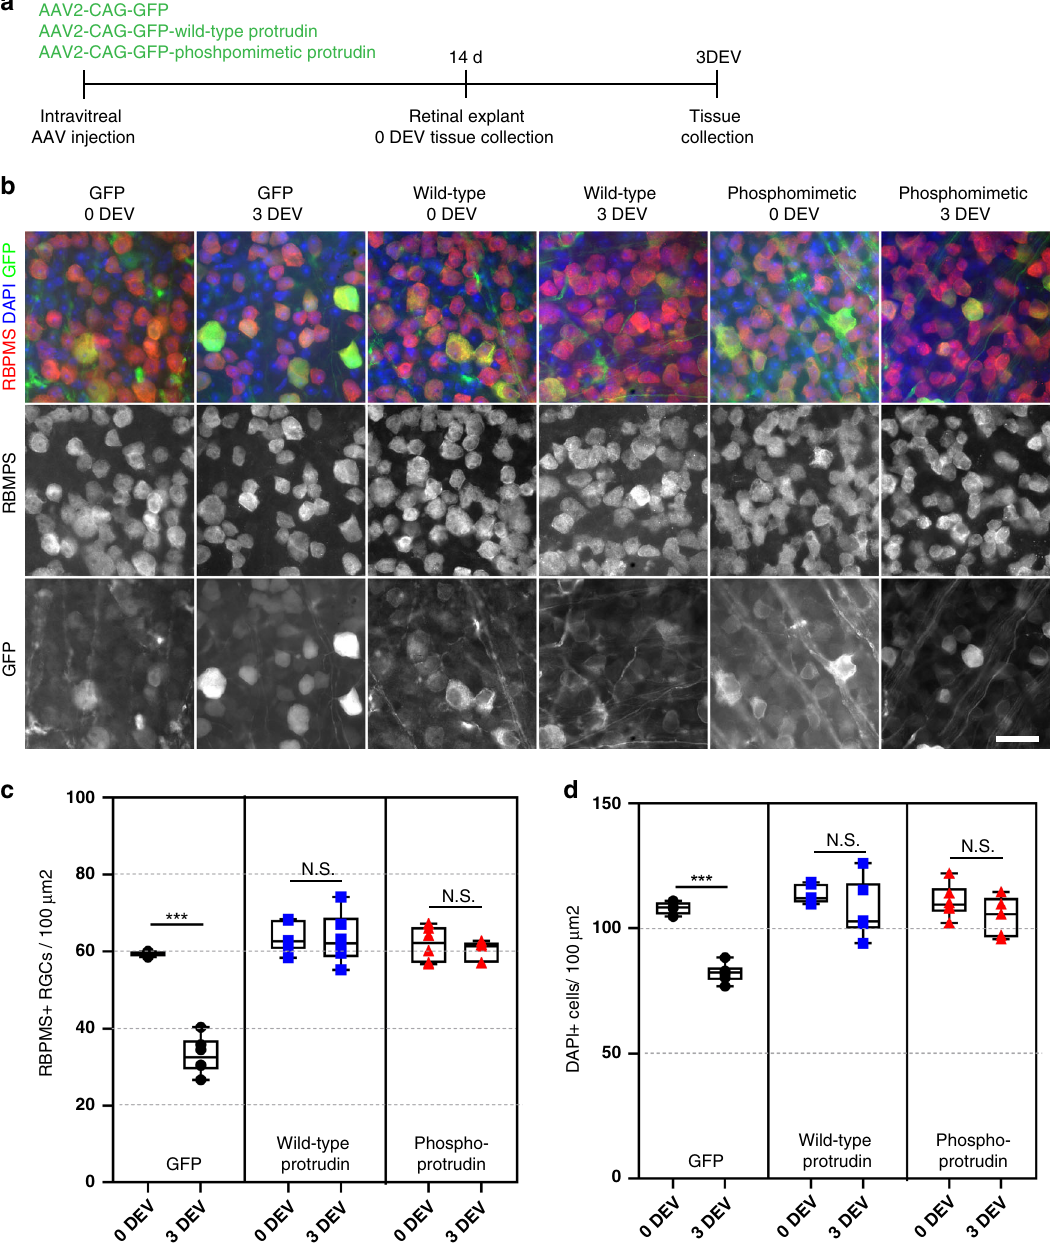
Fig. 6 Protrudin is neuroprotective to RGCs and other cell types in the retina after a retinal explant. a Experimental timeline for retinal explant experiment. b Representative images of RGCs (red for RBPMS) 0 and 3 days ex vivo (DEV) in eyes injected with control virus, wild-type Protrudin or phosphomimetic Protrudin (green for GFP) and stained for DAPI (blue). Scale bar is 20 µ m. c Quanti fi cation of RGC survival in retinal explant ( n = 4 – 6 animals for each condition) (Two-tailed Student ’ s t -test). ** p < 0.005, *** p < 0.001, **** p < 0.0001. Individual p values are as follows: p < 0.0001 for GFP, p = 0.945 for WT and p = 0.439 for phosphomimetic Protrudin when compared at 0 DEV to 3 DEV. The box plots show the fi rst and third quartiles (the box limits), the median (horizontal line), and the minimum and maximum values (whiskers). The circles, squares and rectangles represent individual data points. d Quanti fi cation of DAPI-positive cell survival in retinal explant ( n = 4 – 6 animals for each condition) (Two-tailed Student ’ s t -test). ** p < 0.005, *** p < 0.001, **** p < 0.0001. Individual p values are as follows: p < 0.0001 for GFP, p = 0.234 for WT and p = 0.189 for phosphomimetic Protrudin when compared at 0 DEV to 3 DEV. The box plots show the fi rst and third quartiles (the box limits), the median (horizontal line), and the minimum and maximum values (whiskers). The circles, squares and rectangles represent individual data transfection mixture was added. Dishes were then incubated at 37°C for 30min on a magnetic plate before the original media was returned on the plates. Plasmid reporter gene expression was observed 48 h post-transfection.